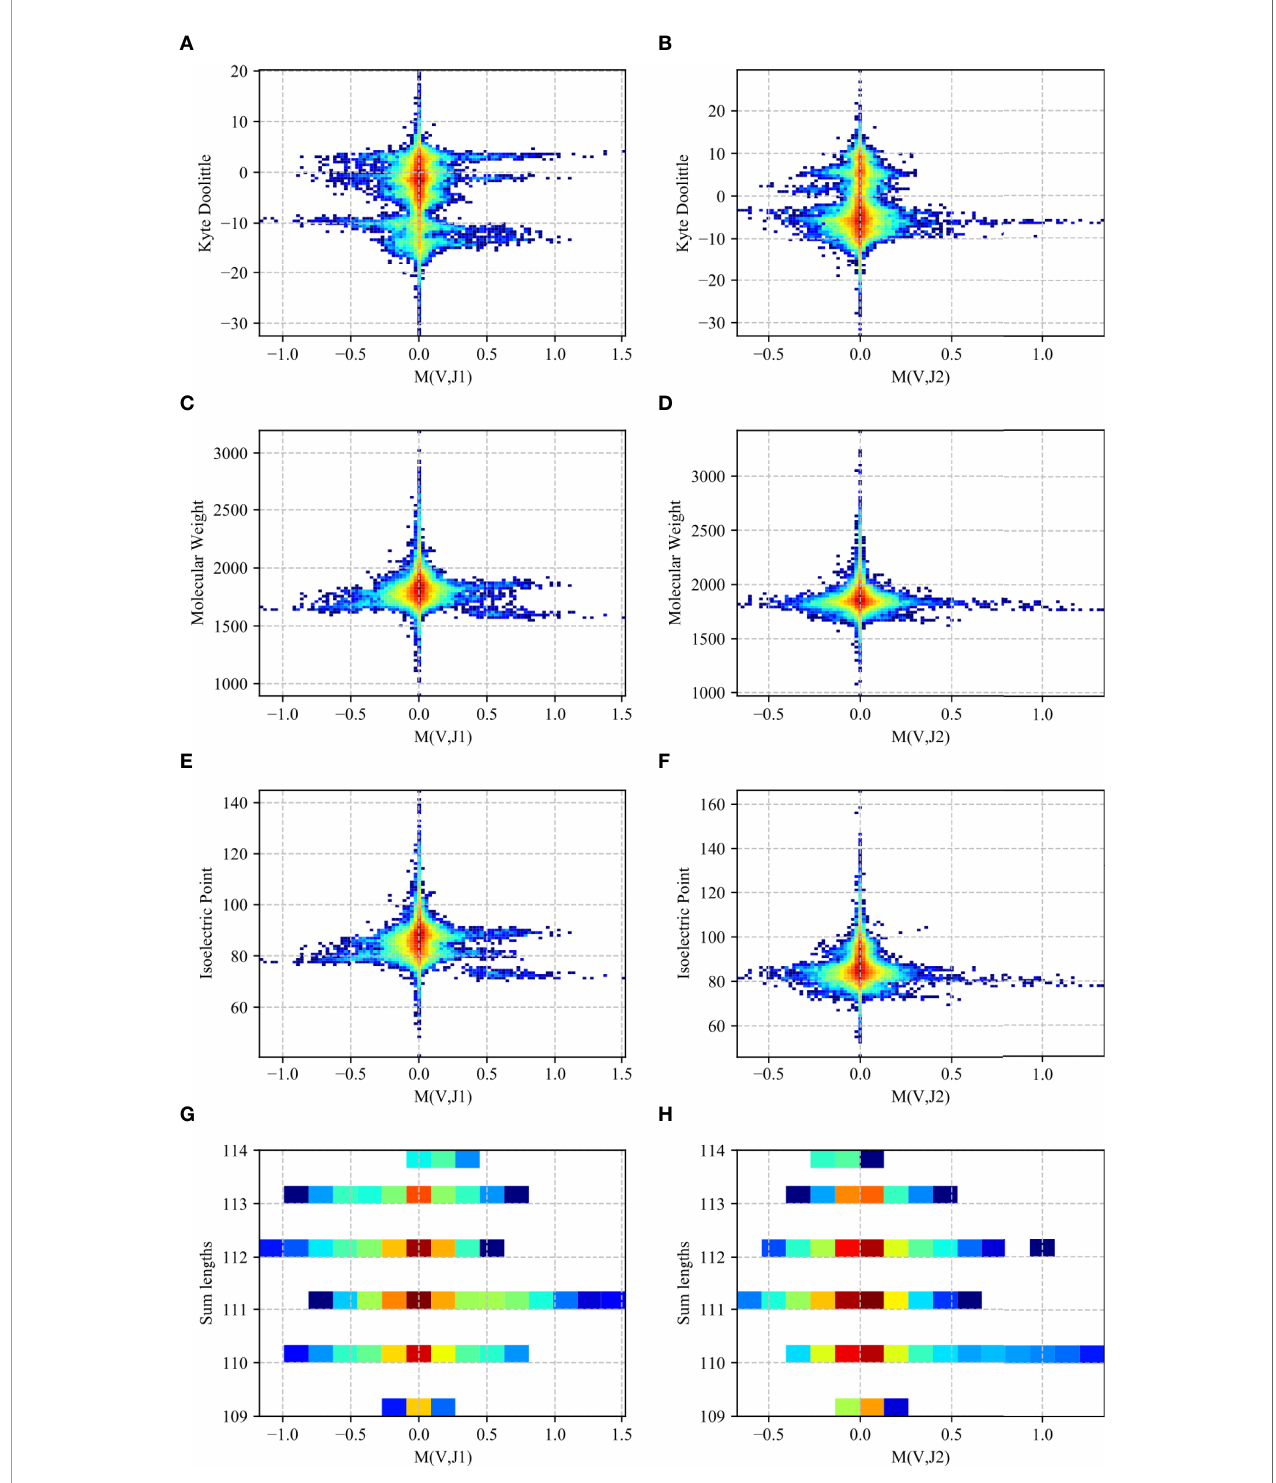
FIGURE 8 | Two-dimensional histogram (RH dataset). 2D histogram where the x-axis represents the M ( V b , J b ) values for the J b 1 family gene (A, C, E, G) and the J b 2 family gene (B, D, F, H) while the y-axis represents the Kyte-Doolittle values (A, B) , Molecular Weight values (C, D) , Isoelectric Point values (E, F) and the sum of the gene lengths values (G, H) . The colors represent the fraction of clones with such a value. Blue colors are low frequencies, while red colors are